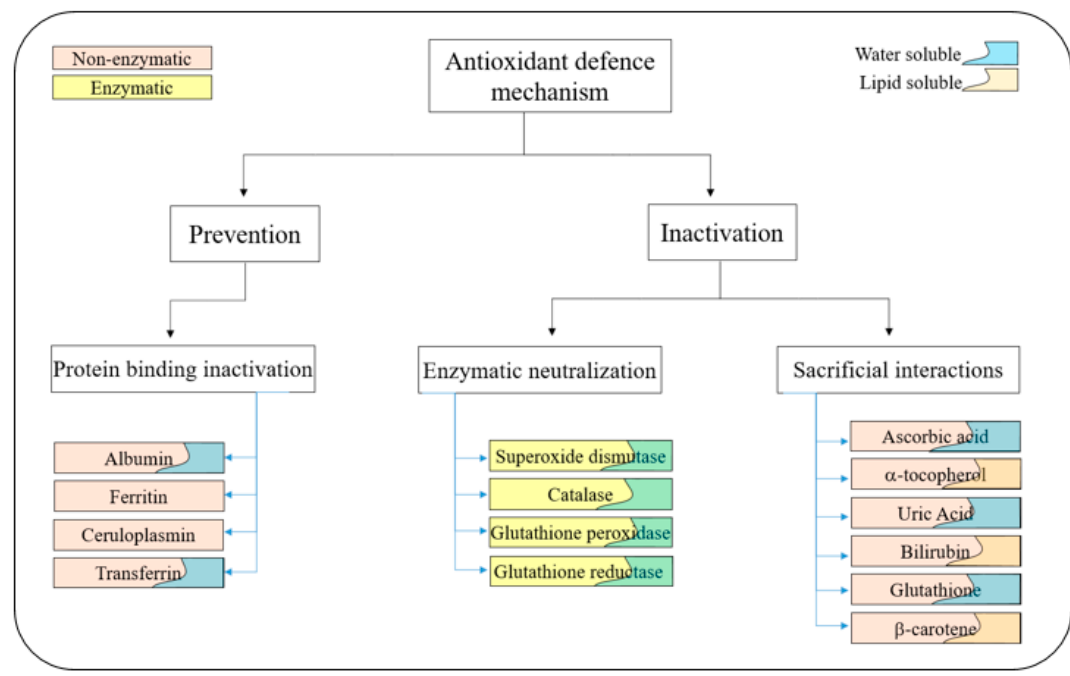
Figure 10. Representation of several types of antioxidants that operate within the eukaryotic organisms.